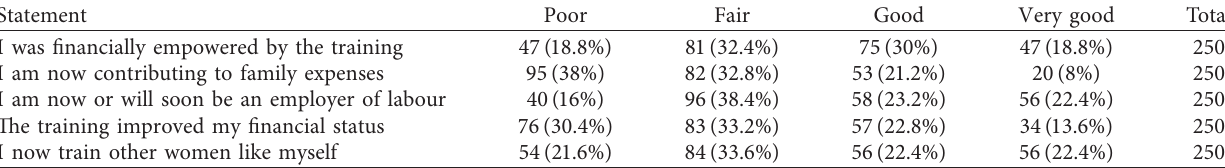
Table 1: Impact of adult literacy/skills acquisition training on women empowerment.